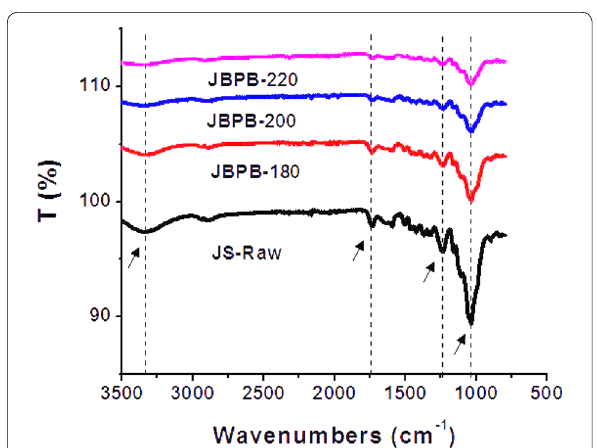
Fig. 3 Fourier transform infrared spectra of jute stick particles